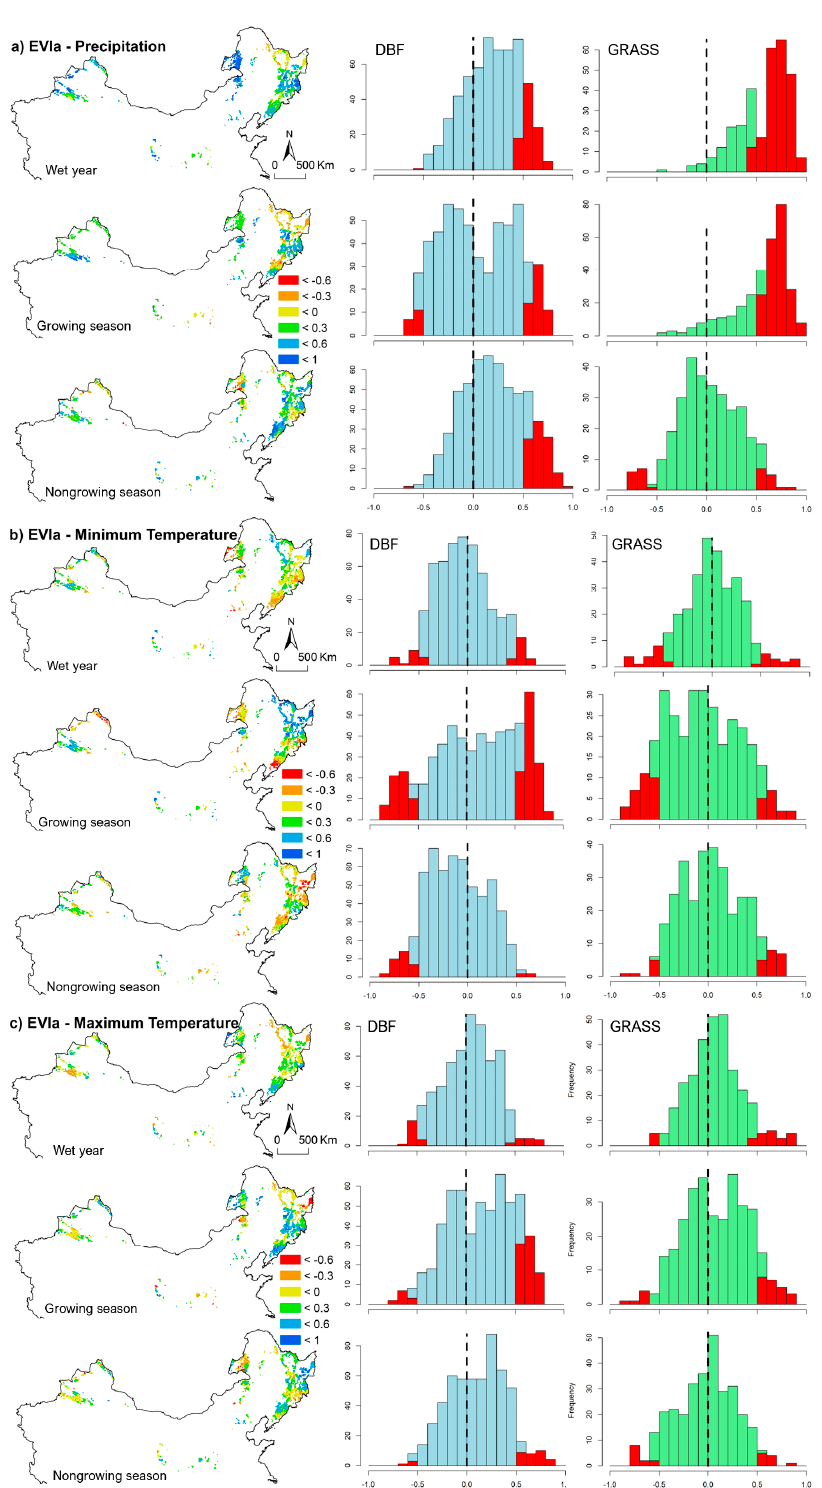
Figure 5. Partial Correlation between EVI a and climate variables of precipitation ( a ), minimum temperature ( b ), and maximum temperature ( c ) during wet year, growing season, and nongrowing season in 2001–2015 for the grassland (GRASS) and deciduous-broadleaved forest patches (DBF). Right columns are histograms of partial correlation coefficients, and red bars on the left side of the dashed line indicate those partial correlations significantly lower than 0 while those on the right side of the dashed line indicate those partial correlations significantly greater than 0 ( p -value < 0.05, one-tail test).